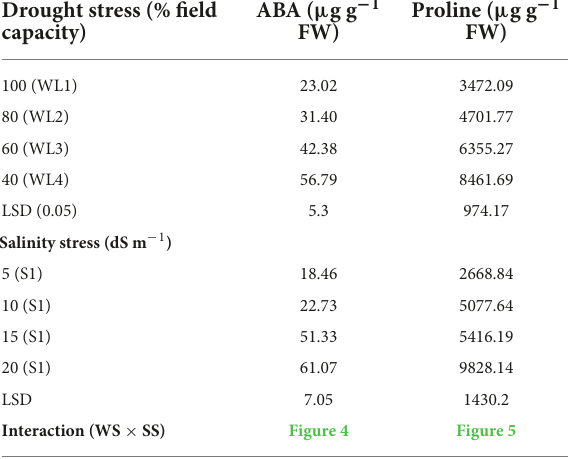
Means with different letters in each category are significantly different at α = 0.05. NS, WS, SS, and LSD stand for non-significant, drought stress, salinity stress, and least